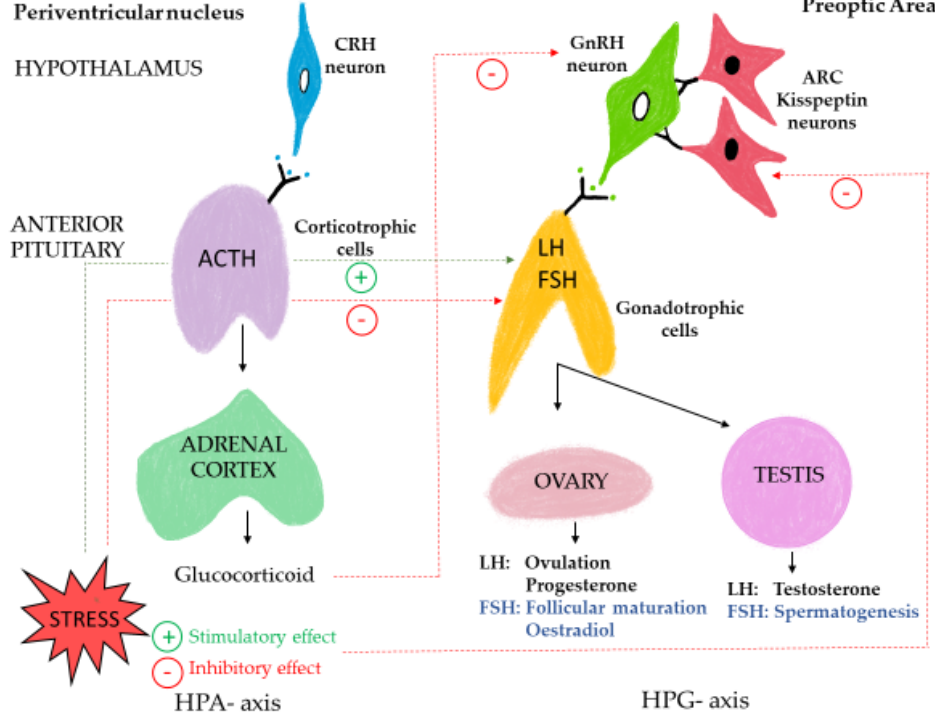
Figure 1. Potential sites along the HPG axis which may be influenced by stress-induced activation of the HPA axis (adapted from